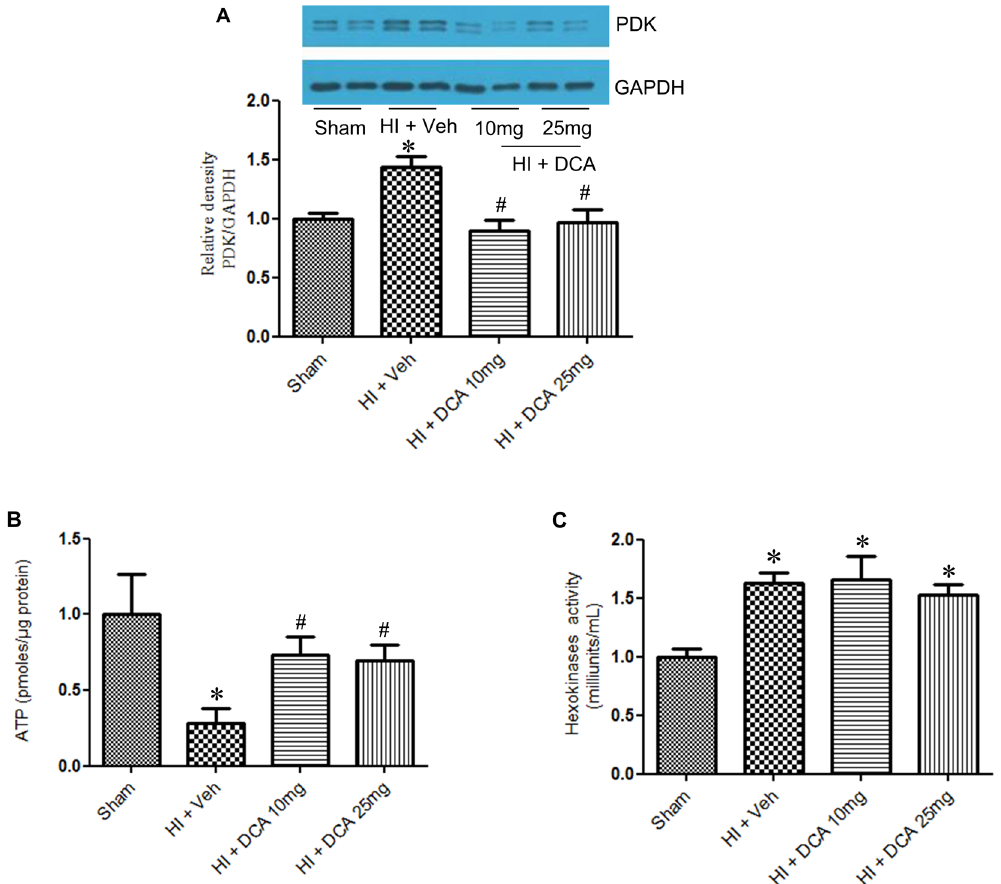
Figure 4. Pdk expression, ATP and hexokinase activity following HI and DCA treatment (Heart). ( A ) Pdk expression in Sham, HI + Veh, HI + DCA 10 mg and HI + DCA 25 mg. The Western blot images are representatives of three independent experiments, scanned from the original and without alteration. ( B ) ATP in heart tissues following HI and DCA treatment. ATP level was measured using a kit from Life Technologies - Molecular Probes. ( C ) Hexokinase activity following HI and DCA treatment: Hexokinase activity was measured by colorimetric method as described in methods section. Groups: Sham, HI + Veh, HI + DCA 10 mg and 25 mg. Bars indicate mean ± SEM; (n = 6), * indicates p < 0.05 for Sham vs respective